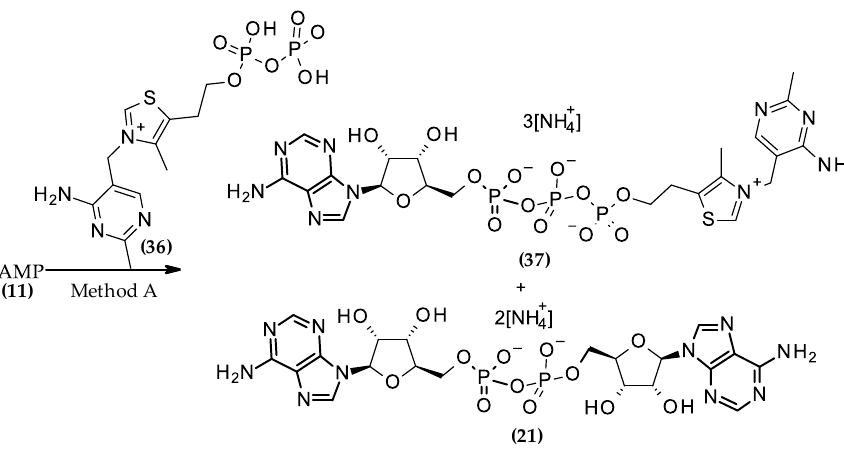
Scheme 4. Synthesis of flavin-nicotinamide dinucleotide ( 33 ), flavin-adenine dinucleotide (FAD) ( 35 ) and cyclic-FMN ( 34